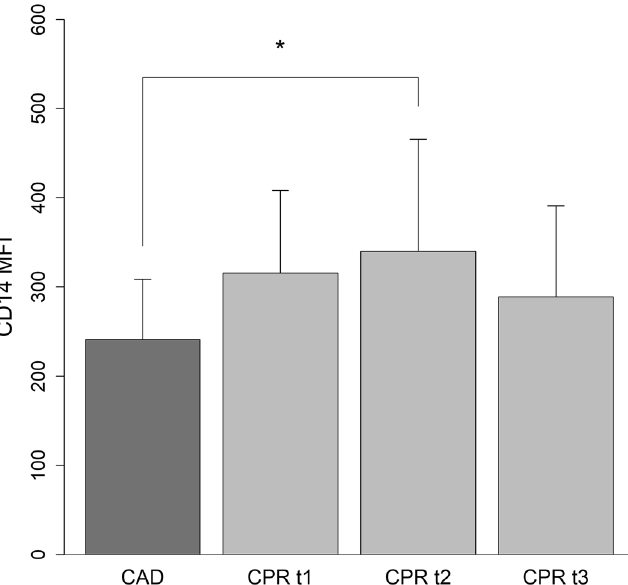
Figure 2. Monocyte CD14 surface expression is increased in patients after cardiac arrest. Shown is the surface expression of CD14 from resuscitated patients’ circulating monocytes during the first 12 h (CPR t1: n = 22), after 24 h (CPR t2: n = 21), and 48 h (CPR t3: n = 16) following cardiac arrest, and from the control group (CAD: n = 19). Statistical hypothesis testing was performed by one-way analysis of variances and post-hoc analysis with all-pairwise comparisons using the Dunn–Bonferroni approach (*: p ≤ 0.05). A significant upregulation of CD14 was already observed within the first 12 h ( p = 0.05) and after 24 h following ROSC ( p = 0.006), when multiple